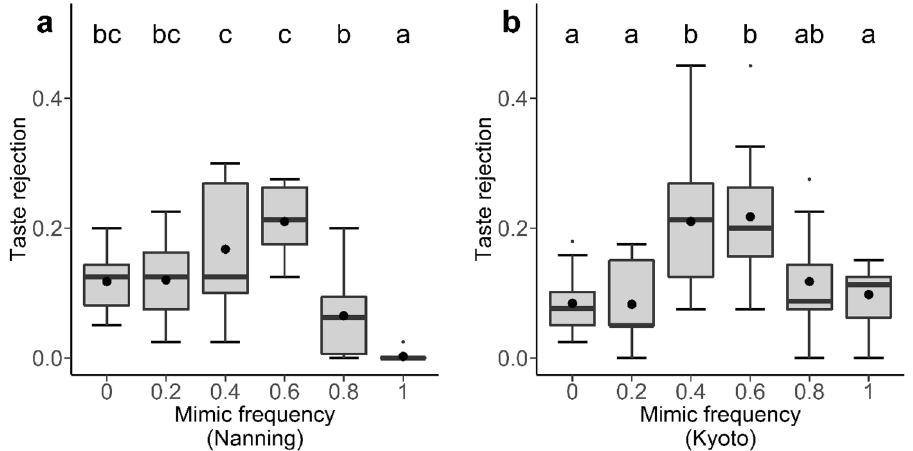
Figure 2. The proportion of prey that were taste rejected by birds at different mimic frequencies in Nanning ( a ) and Kyoto ( b ). The letters indicate commonalities among groups. Black dots represent mean values of each column. Each box represents 10 data